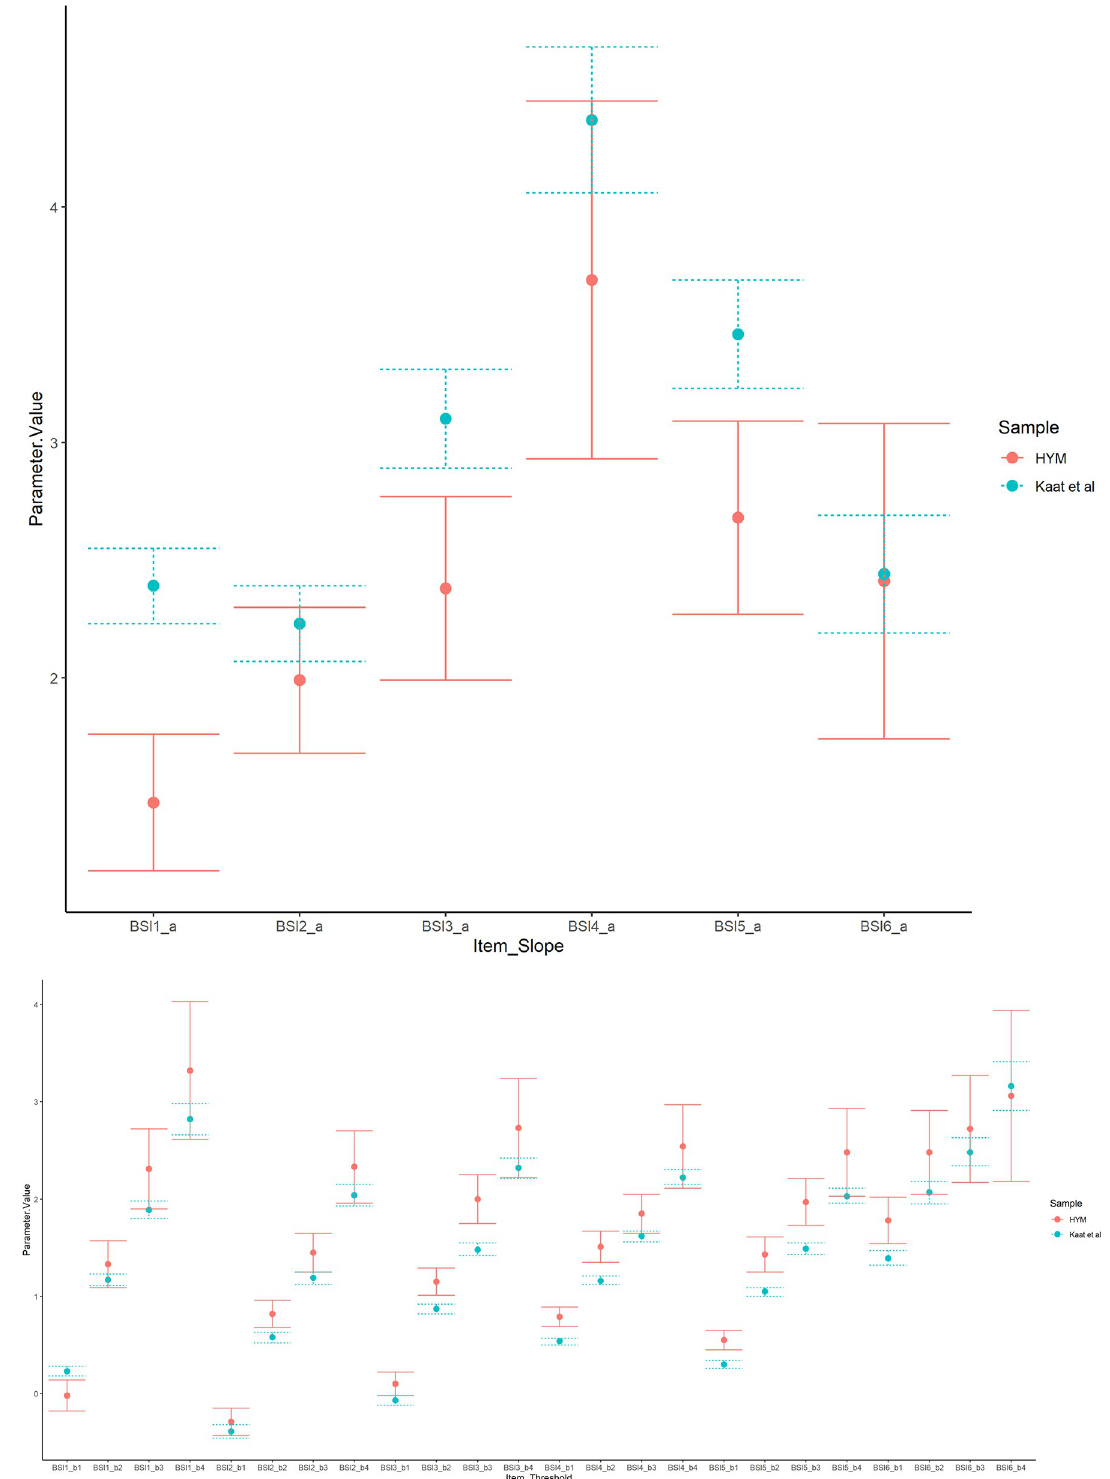
Fig 1. Item parameters and confidence intervals of the two studies. Note . Fig 1a: the slope parameters. Fig1b: the threshold parameters.